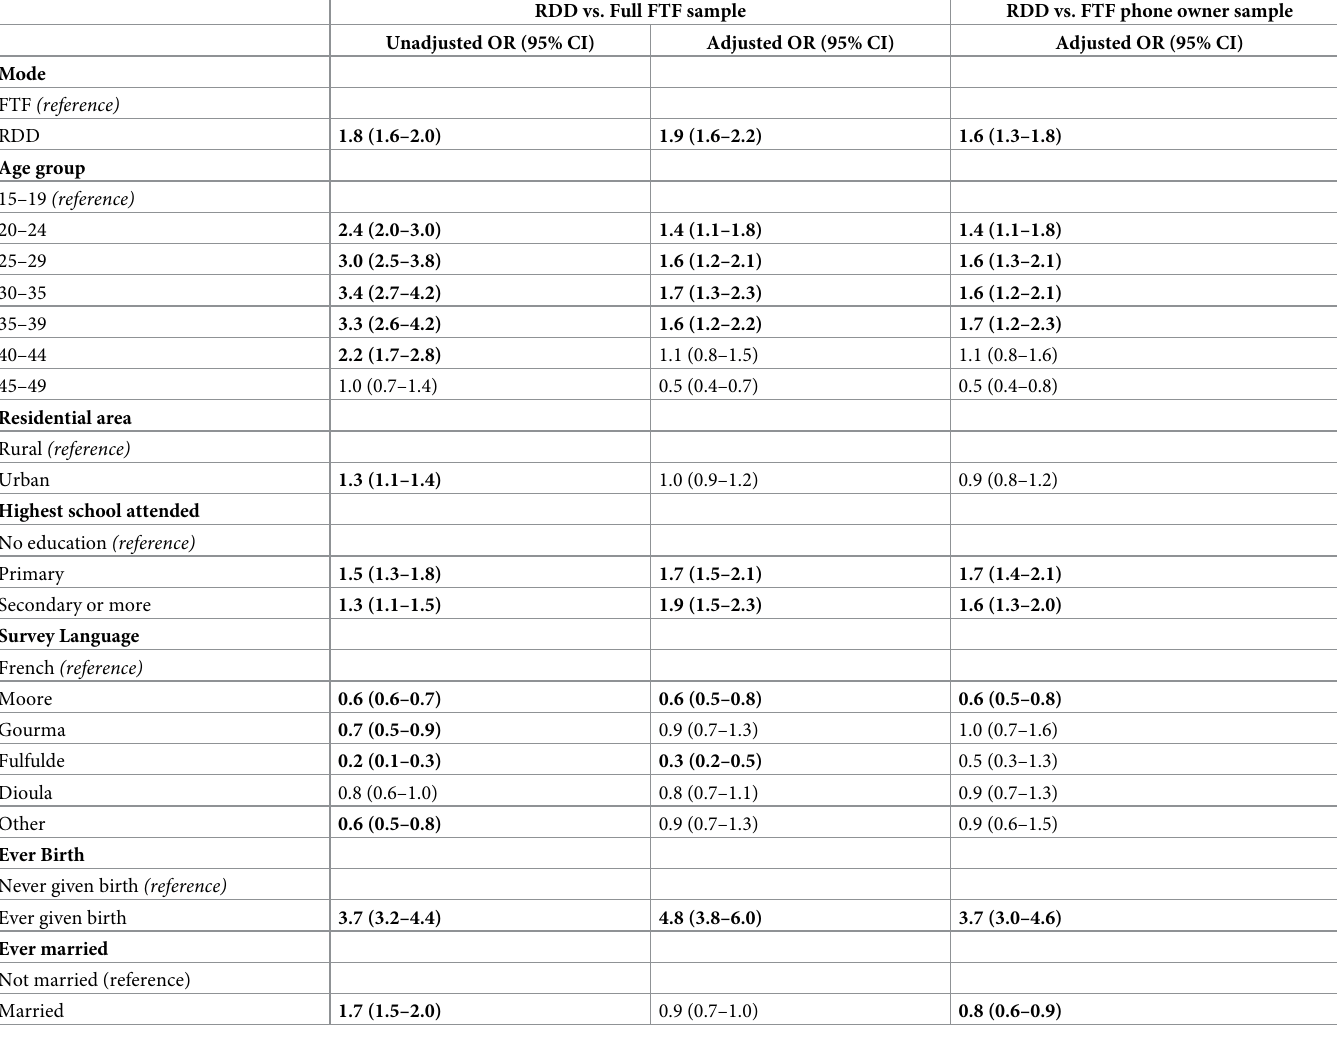
Table 5. Odds of reporting modern contraceptive use by women’s characteristics and survey mode, using full FTF sample and FTF phone owner sample. RDD vs. Full FTF